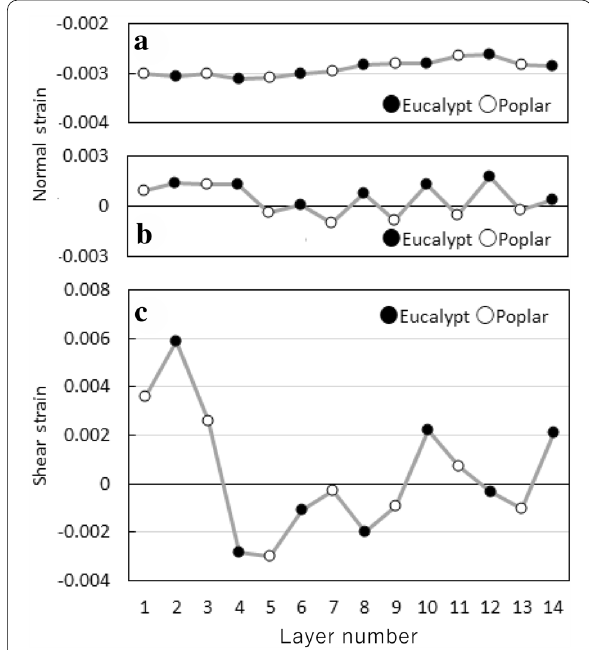
Fig. 10 Strain distribution of the mixed-species 17-ply LVL (PE-LVL) along the laminated direction; horizontal axis: layer number; a normal strain in the loading direction, b normal strain in the laminating direction, c shear